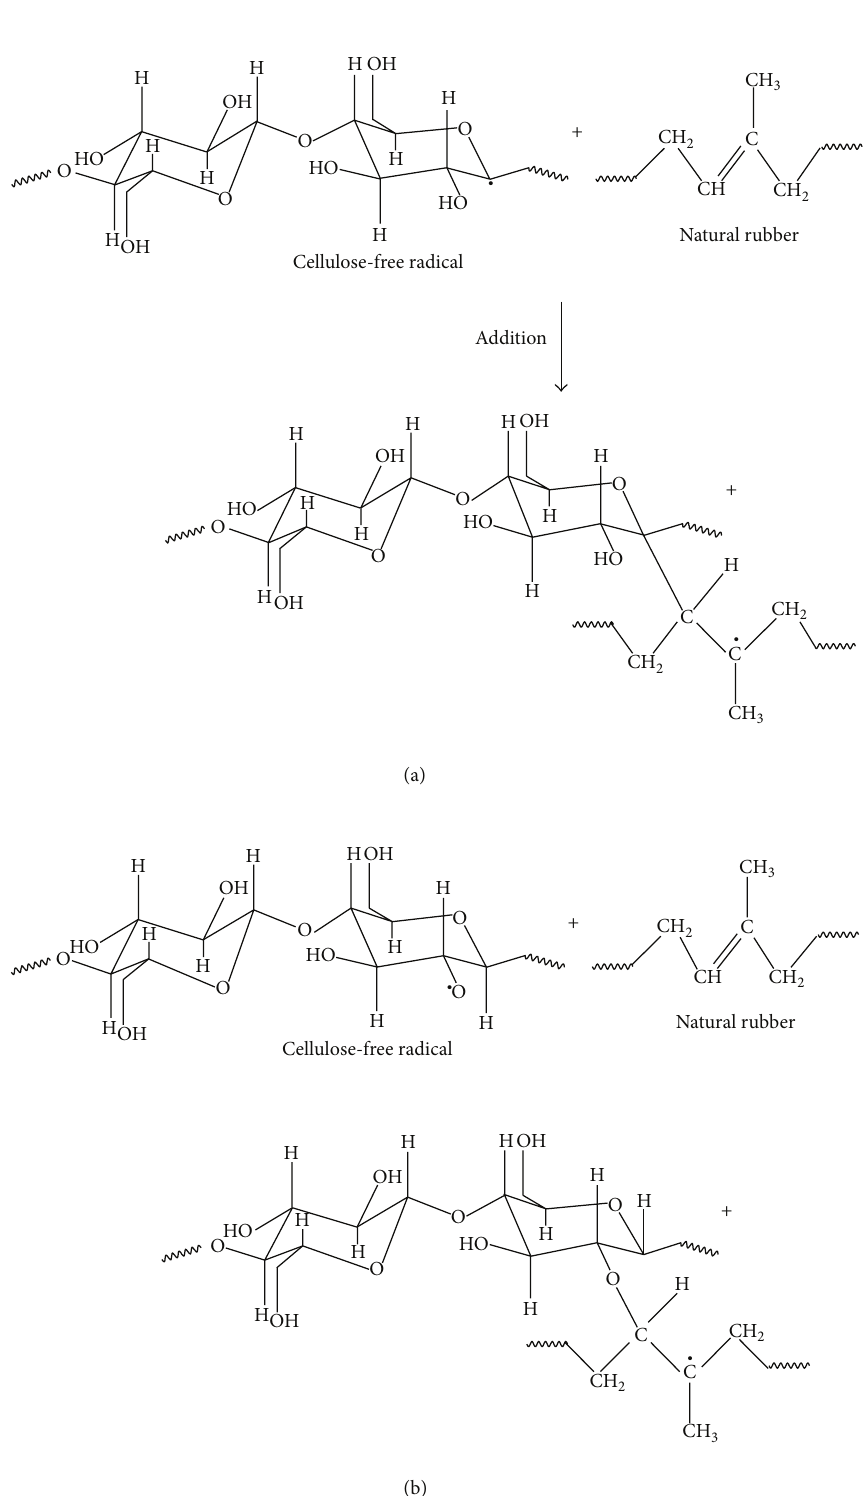
Scheme 4: Proposed mechanism for the interaction between cellulose and natural